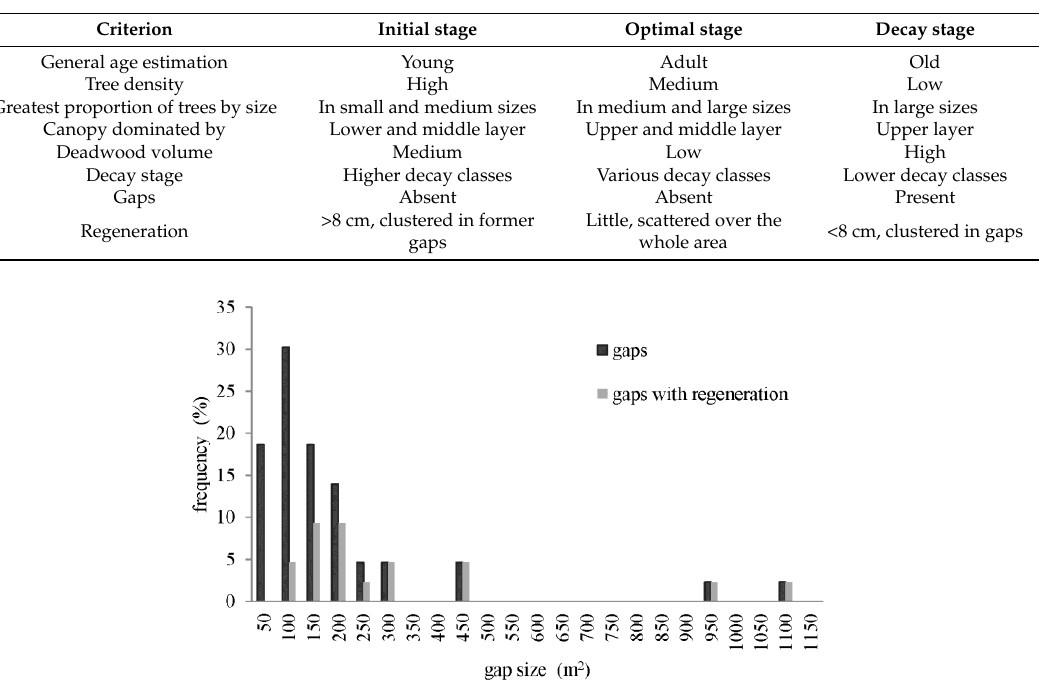
Table A2. Indicative criteria for stage determination (sensu [2,12]) modified according to local conditions.